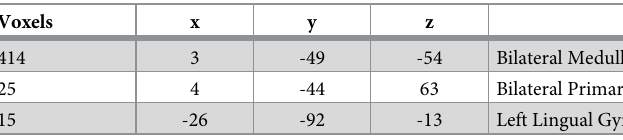
Table 4. Cluster results of group × time × GSR LME